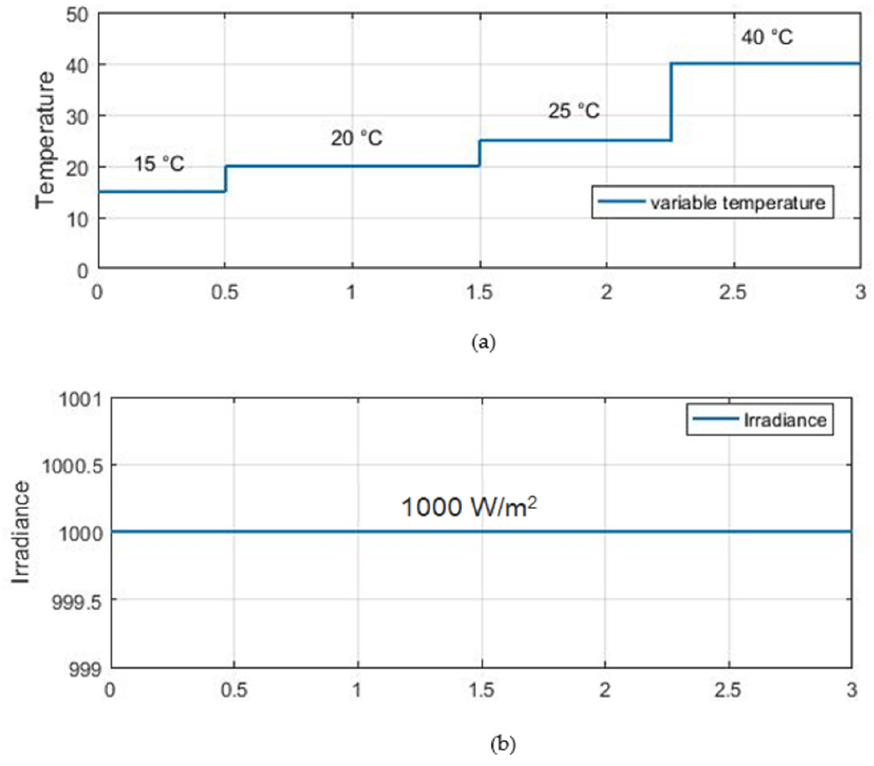
Figure 10. ( a ) Ramp change of temperature level. ( b ) Invariable irradiance, set at 1000 W/m 2 . In Figure 11 below, the output current, voltage, and power are presented